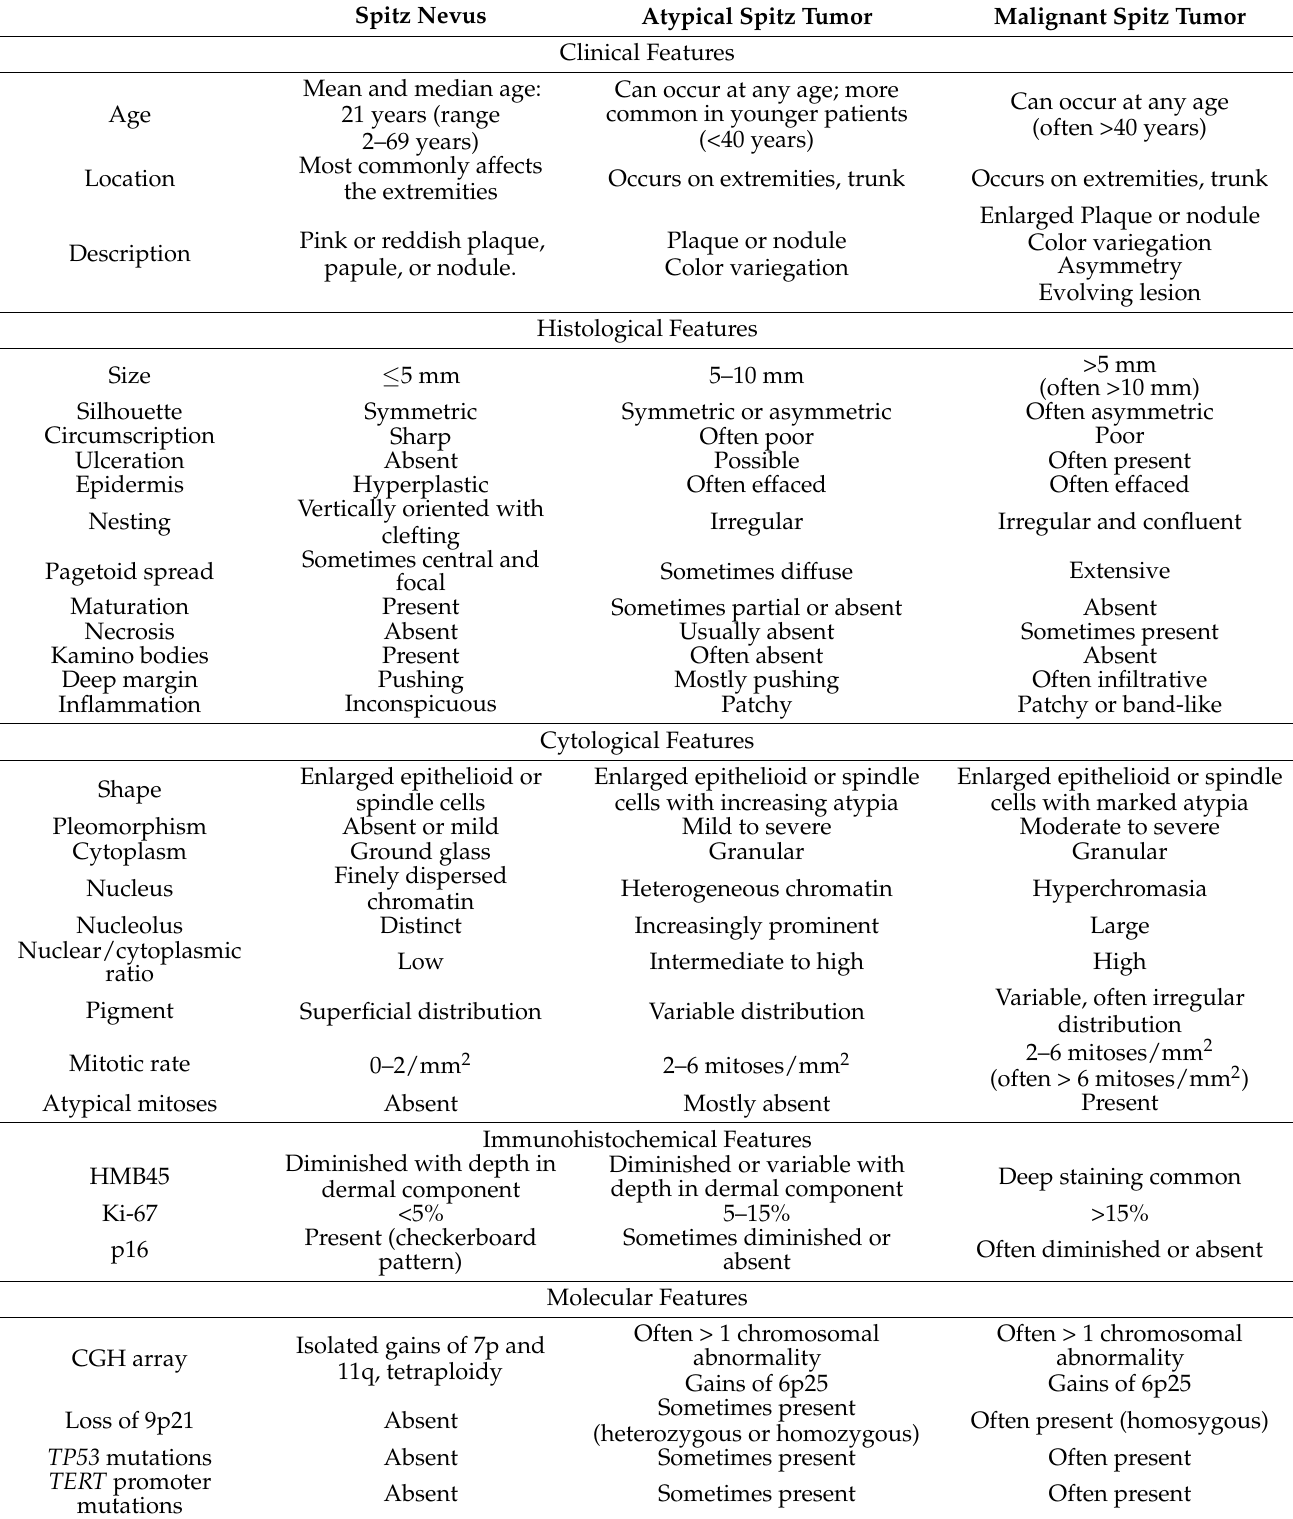
Table 1. Clinical, histological, immunohistochemical, and molecular features of Spitz